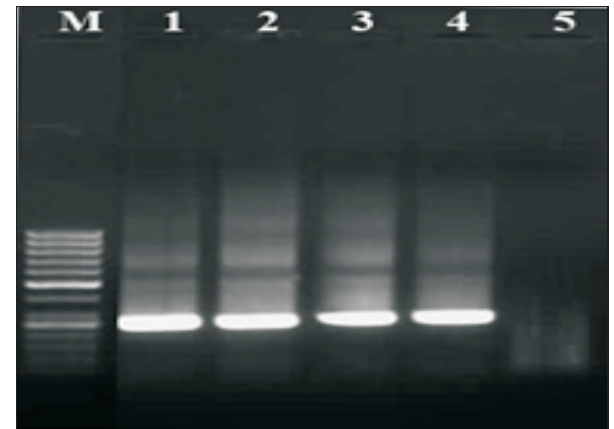
Figure-3: Cover slip preparation of MDBK cell infected with BHV-1 virus showing CPE (cell lysis, Cowdry type A intranuclear inclusion bodies) H&E stain.